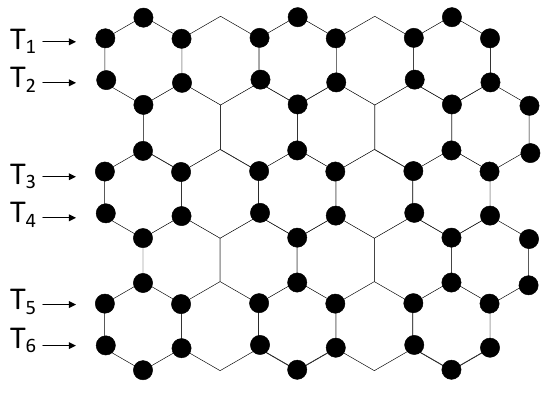
Figure 6. T 1 ∪ T 2 ∪ · · · ∪ T 6 on H 5,5